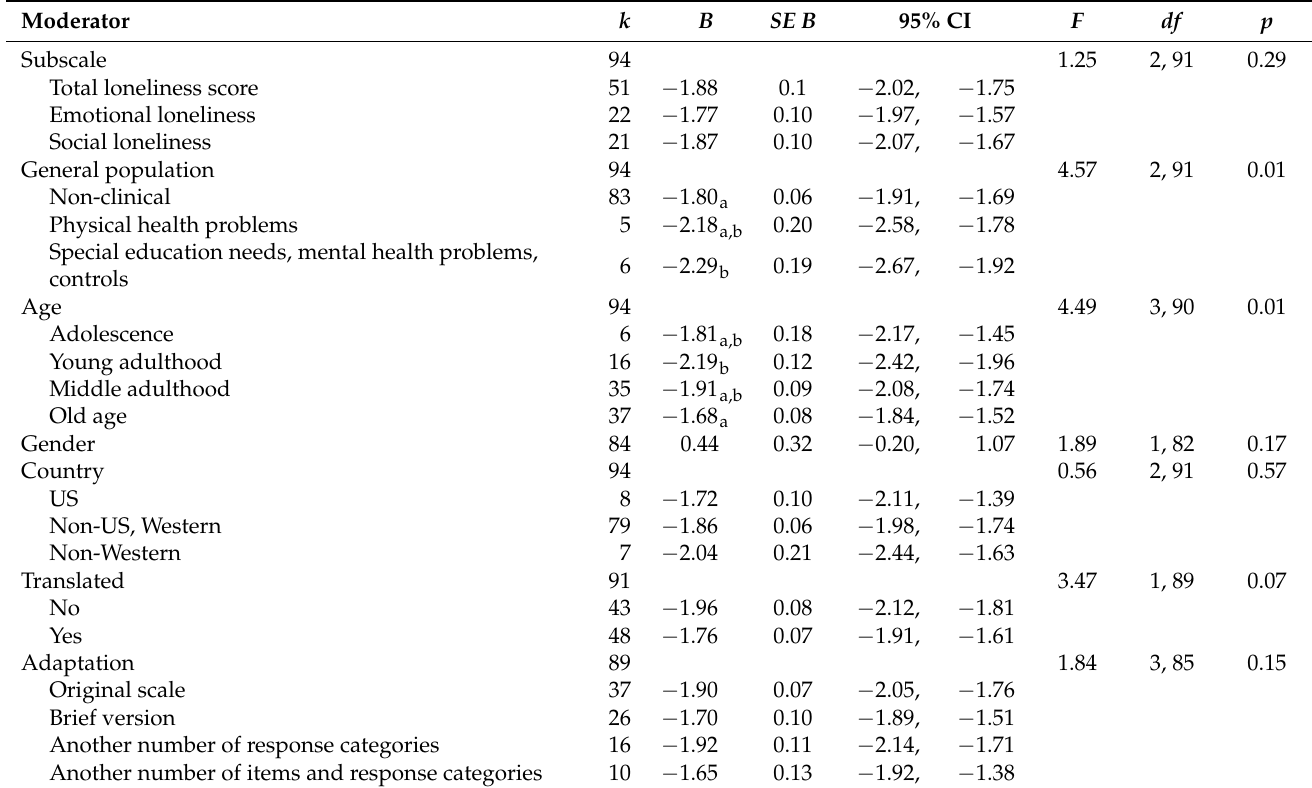
Table A2. Separate Regression Analyses for the Moderators Predicting Reliability Scores of the Rasch-Type Loneliness Scale (RTLS).